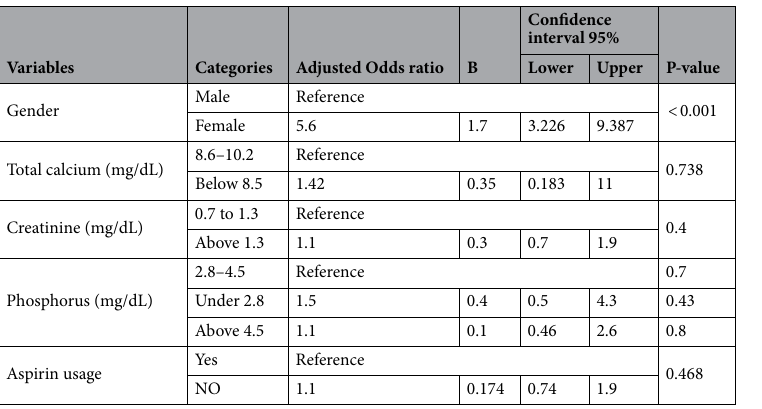
Table 4. Binomial logistic regression between the occurrence of fracture due to a fall from standing height or less (1 time or more) and other